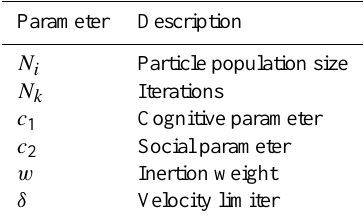
Table 5. Overview of PSO algorithm